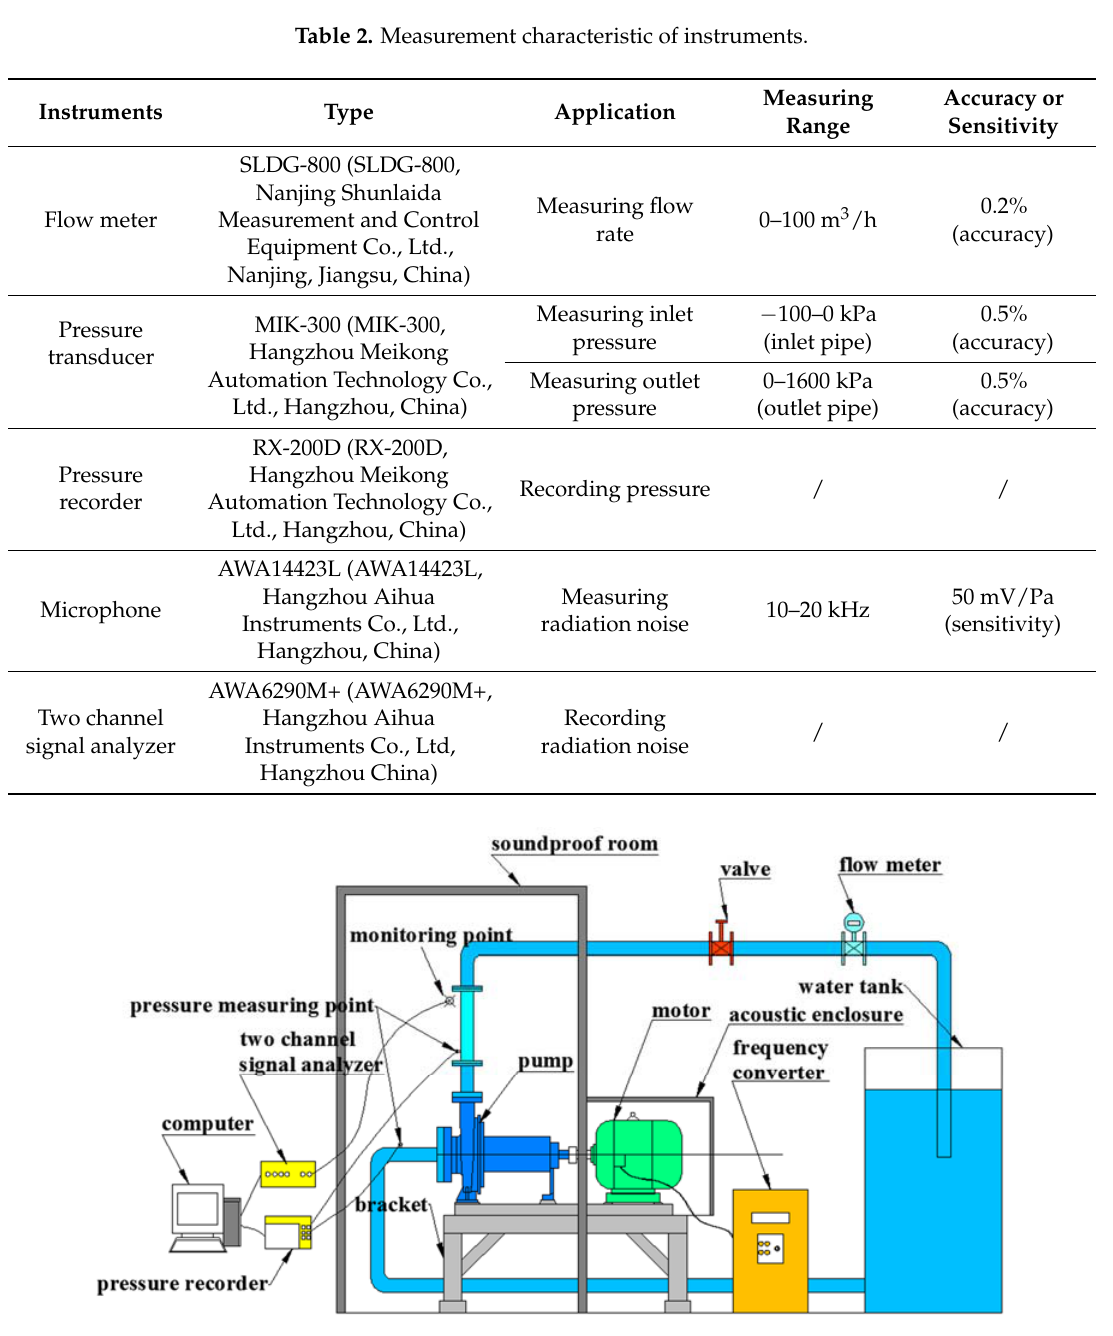
Figure 2. Layout and instrumentation of measurement system.